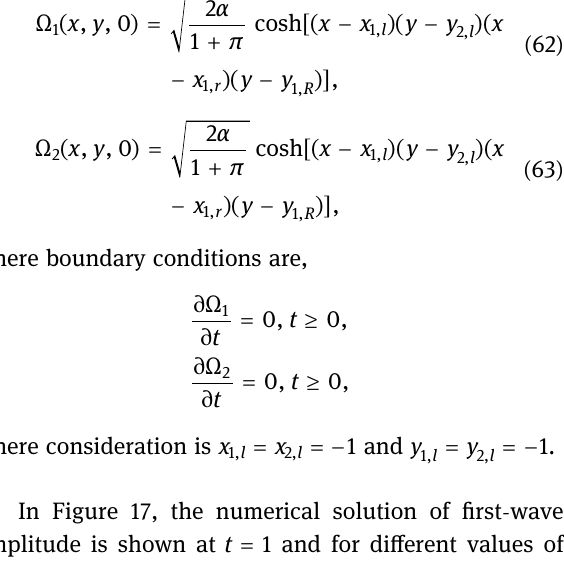
tension parameter. In Figure 18, contour representation